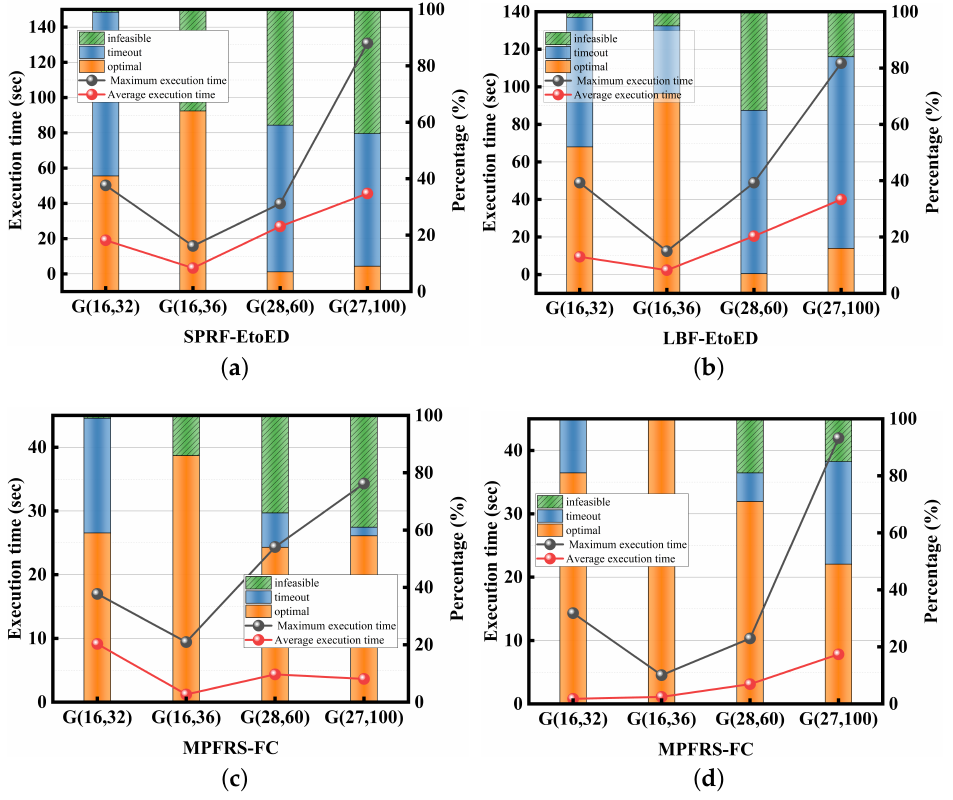
Figure 13. Percentage of solved, timeout, and infeasible schedules and execution time of the SPRF- EtoED, LBF-EtoED, MPFRS-FC, and APCRS-FC for 100 test cases with 40 flows chosen from flow group 1, tested in MM network. ( a ) Technique 1: SPRF-EtoED. ( b ) Technique 2: LBF-EtoED. ( c ) Tech- nique 3: MPFRS-FC. ( d ) Technique 4: